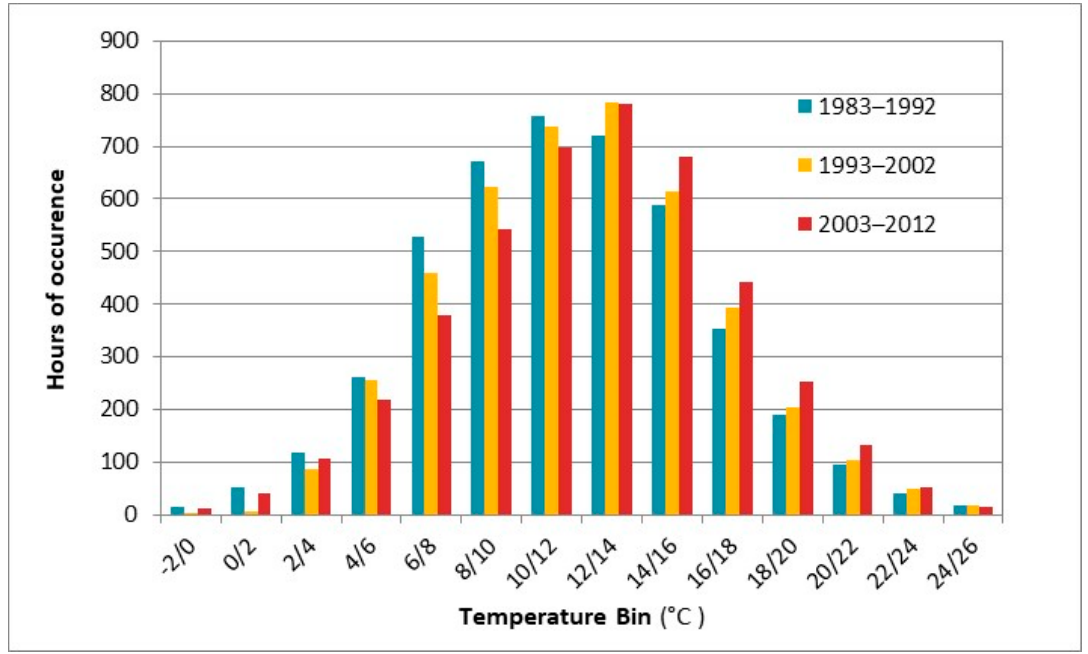
June to September).